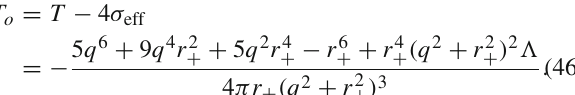
Fig. 10 Plot of G versus T of the RBH with cosmological constant in NED RBH with cosmological constant. Thus, for the lower neg- ative values of surface tension, the Gibbs free energy have positive higher values. But T o is,